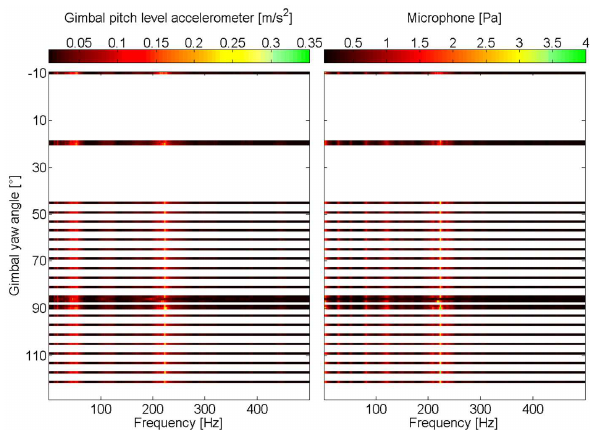
Figure 12. Spectrogram of vibration and acoustic pressure measure- ments of the pitch level plate for different gimbal yaw angles aver- aged over the whole flight 8 on HALO on 28 August 2012. Only discrete gimbal yaw angles are illustrated, as only those angles are used during the